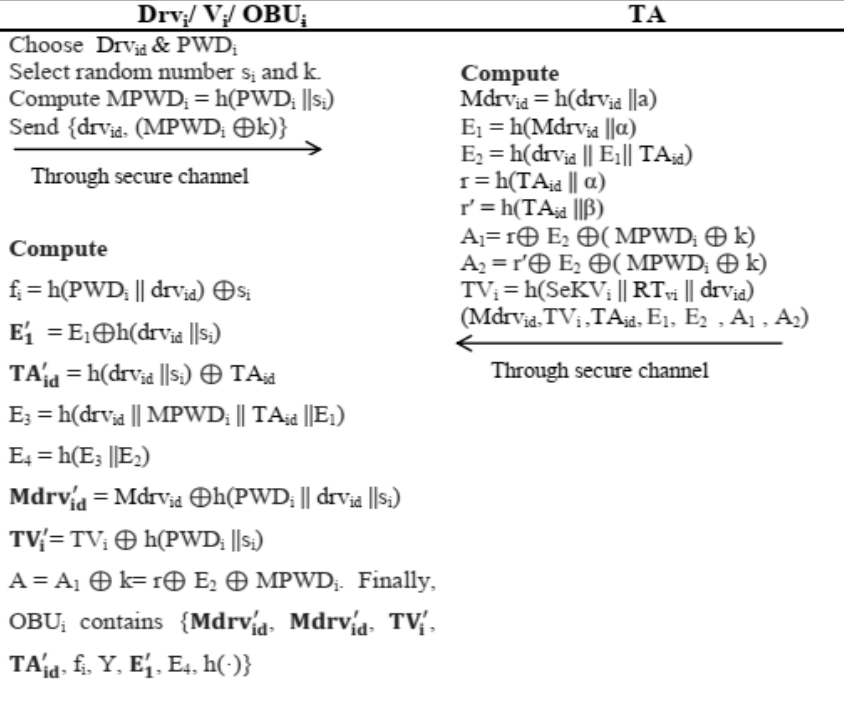
Figure 3. Vehicle Registration Phase.